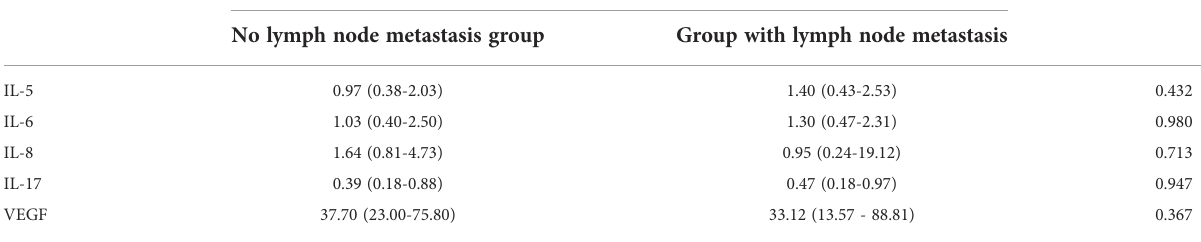
TABLE 4 Serum IL-5, IL-6, IL-8, IL-17, VEGF levels and lymph node metastasis in breast cancer patients.